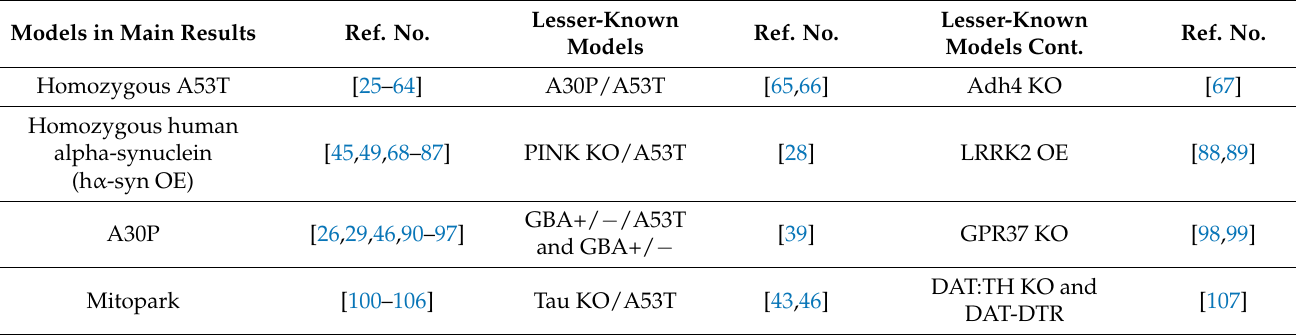
Figure 2. Pie chart of ( A ) the range and number of animal models identified via Pubmed search. ( B ) The number of phenotypes investigated by the studies. ( C ) Proportion of studies investigating MDS criteria phenotypes compared to all published studies using the animal model. The width of x -axis represents the total number of studies fitting the inclusion criteria, and y -axis represents proportion of overall literature using the model. ˆCD157KO proportion = 4/4. Table 1. All genetic models and references included in the review. Results from lesser-known models used in 2 or fewer studies were not included in the main results and can be found in Supplementary Table